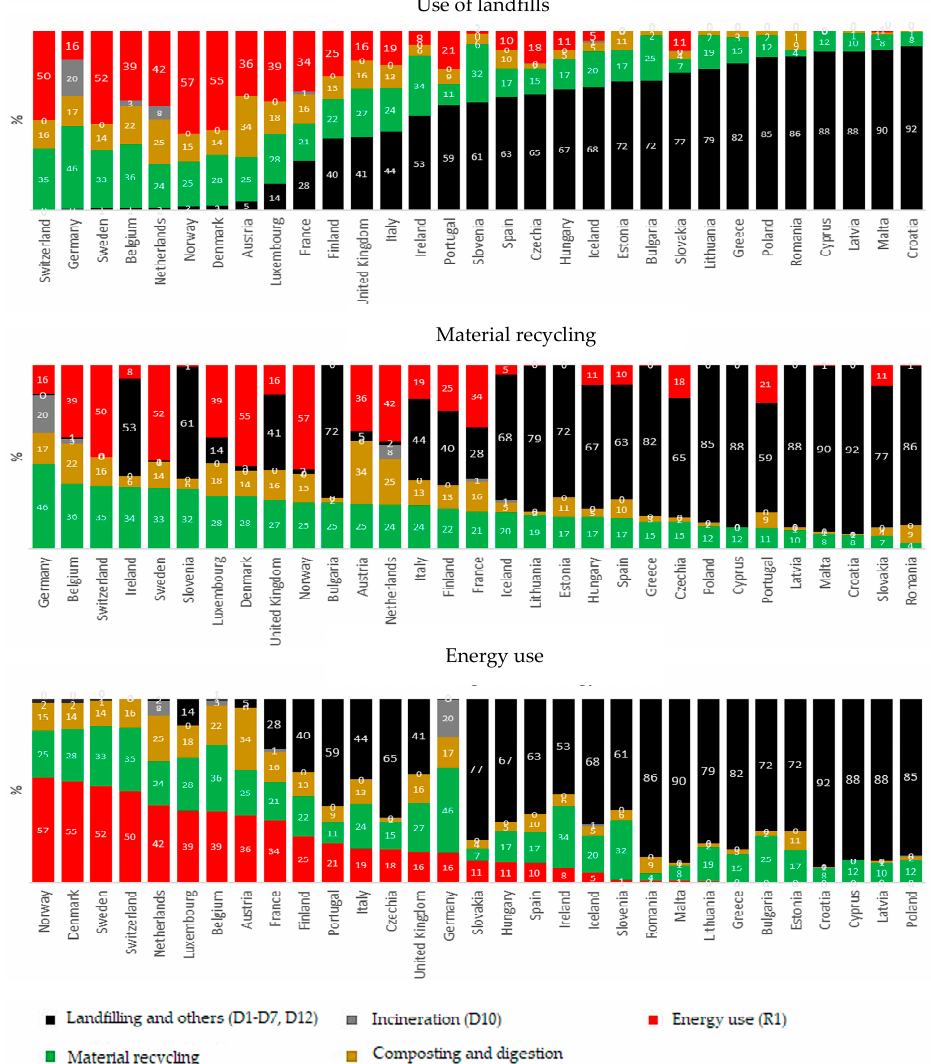
Figure 5. Ranking of countries by waste treatment process in 2011.